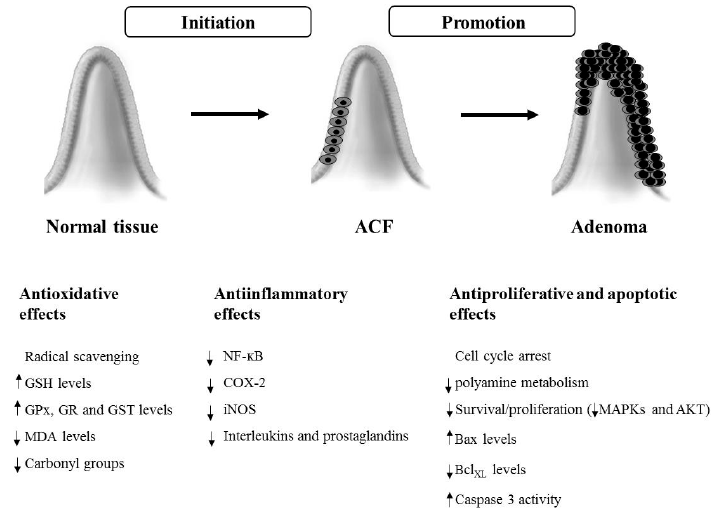
Figure 2. Mechanisms involved in the potential chemopreventive effects of cocoa and its flavonoids against colorectal cancer. The arrows indicate an increase ( ↑ ) or decrease ( ↓ ) in the levels or activity of the different analysed parameters. ACF, aberrant crypt foci.